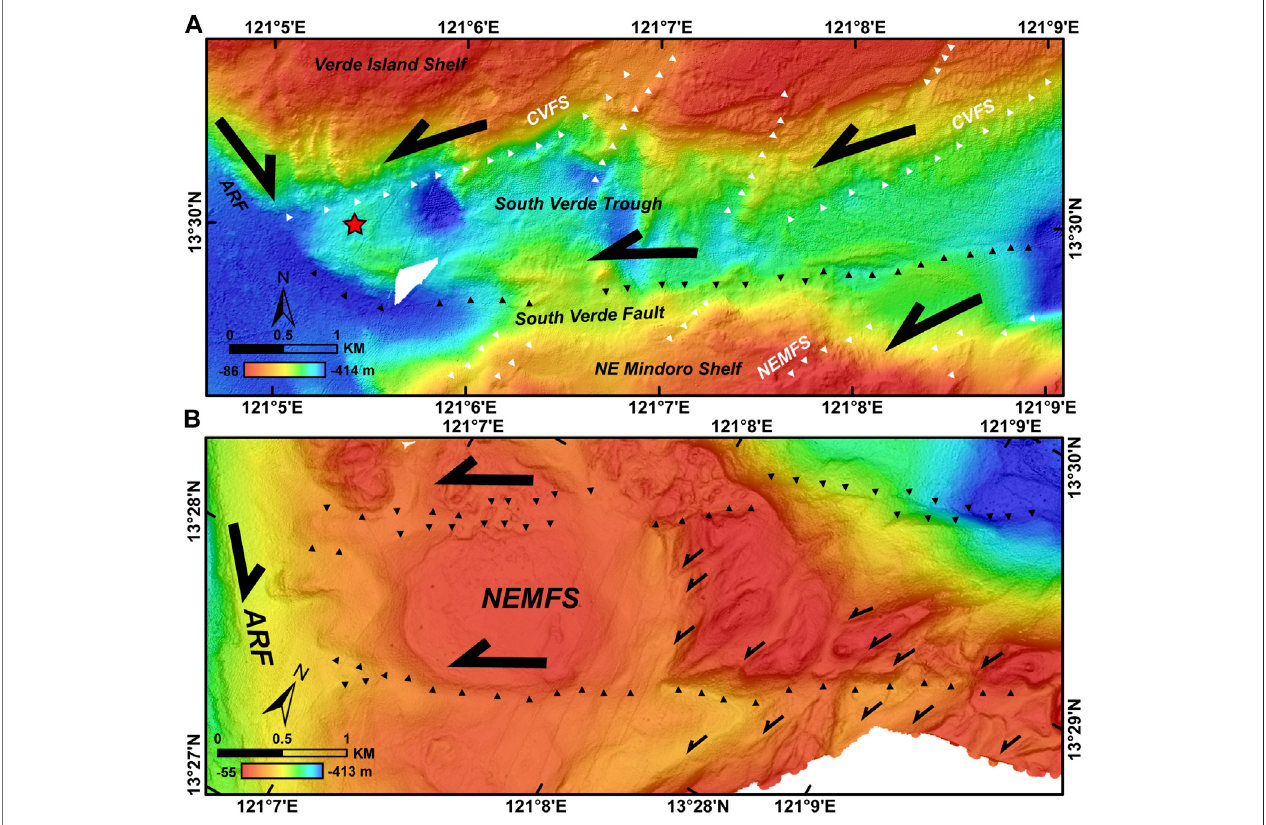
FIGURE 5 | (A) Closeup of the South Verde Trough. Black arrowheads show the trace of the South Verde Fault. White arrowheads point to the NE-trending structures of the Central Verde Fault System (CVFS) and Northeast Mindoro Fault System (NEMFS). Black half arrows indicate fault motion. The epicenter of the 1994 earthquake is shown as a red star. (B) Closeup of the Northeast Mindoro Shelf. Black arrowheads point to the longer faults of NEMFS. Smaller half arrows indicate the motion of shorter faults (Riedel shears). Please refer to Figure 2 for the location of the fi gures. ARF, Aglubang River